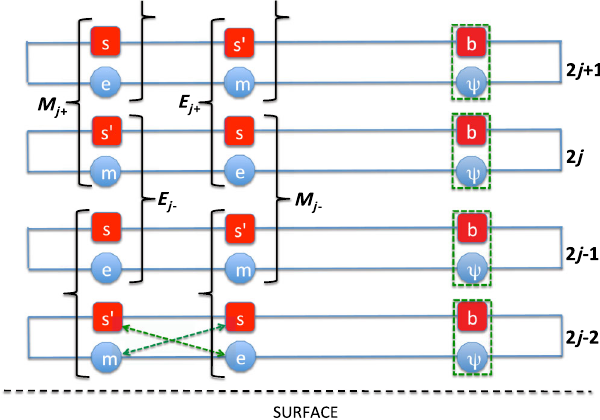
FIG. 7. Coupled-layer construction of semion-fermion topo- logical order on the surface of a 3D topological superconductor (with even (cid:1) ). Each layer has a double-semion model and a Z 2 gauge theory. The composite excitations enclosed by the brack- ets can be condensed simultaneously, after which the only deconfined excitations in the bulk are electrons, c ¼ b c , shown by the dashed green boxes. At the surface, two additional excitations emerge—shown by the dashed green lines—which are exchanged by T . A key ingredient is that the two bosons gauge theory are (electric and magnetic charges) of the Z 2 exchanged by T , which requires T 2 ¼ (cid:1) 1 acting on